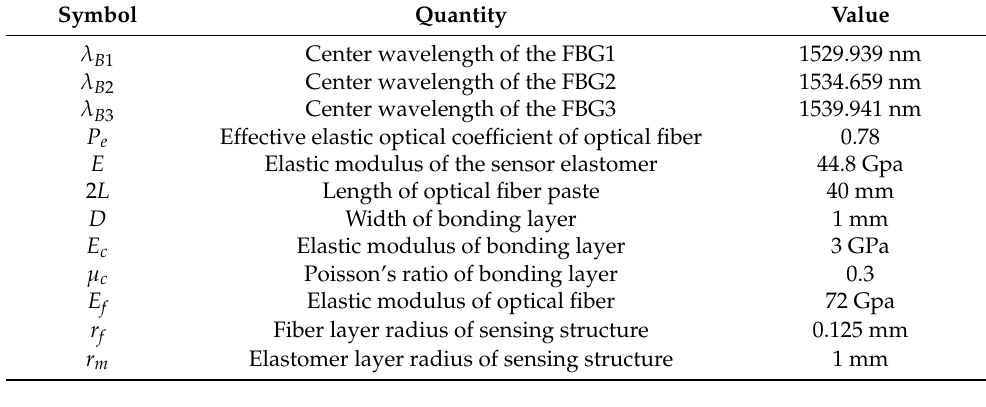
Table 1. Structural material parameters of FBG three-dimensional stress sensor.